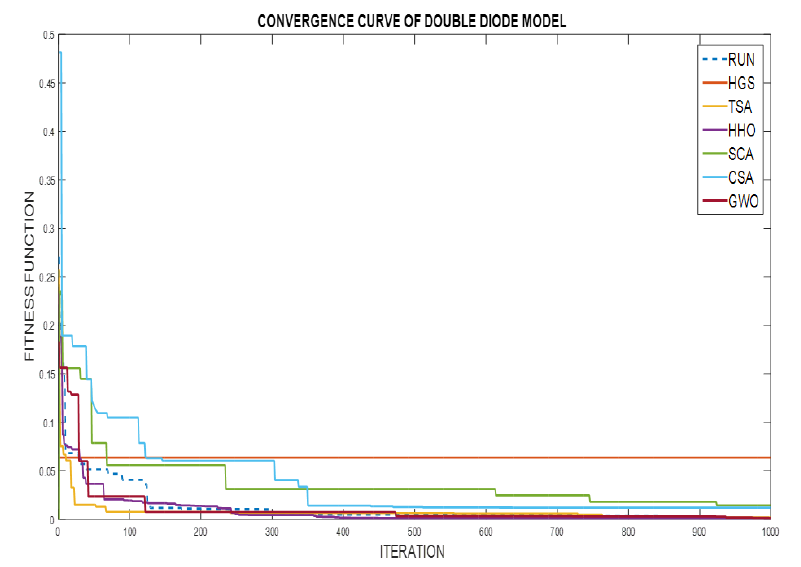
Figure 13. Convergence curve for SDSCM.